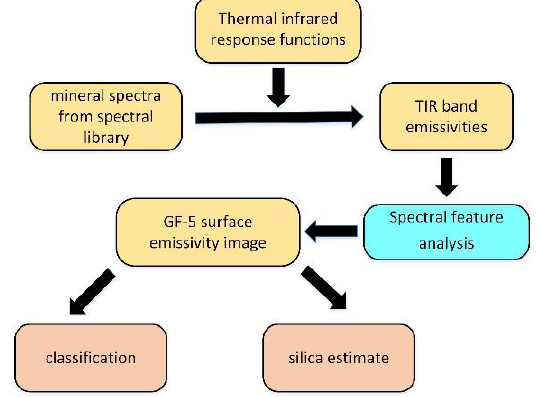
Figure 3. Flow chart used in the study.